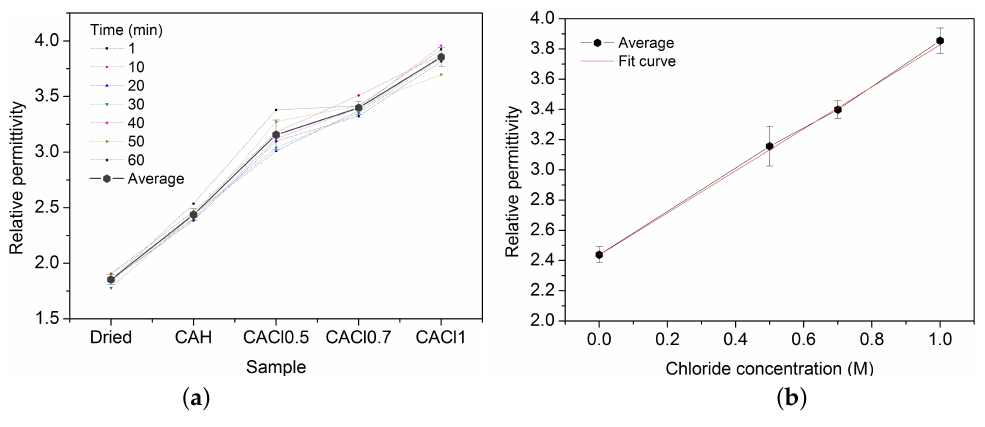
Figure 7. ( a ) Effect of chloride content on measured relative permittivity for CA dried and exposed to 0 M, 0.5 M, 0.7 M and 1 M NaCl solutions; ( b ) Correlation between chloride concentration and relative